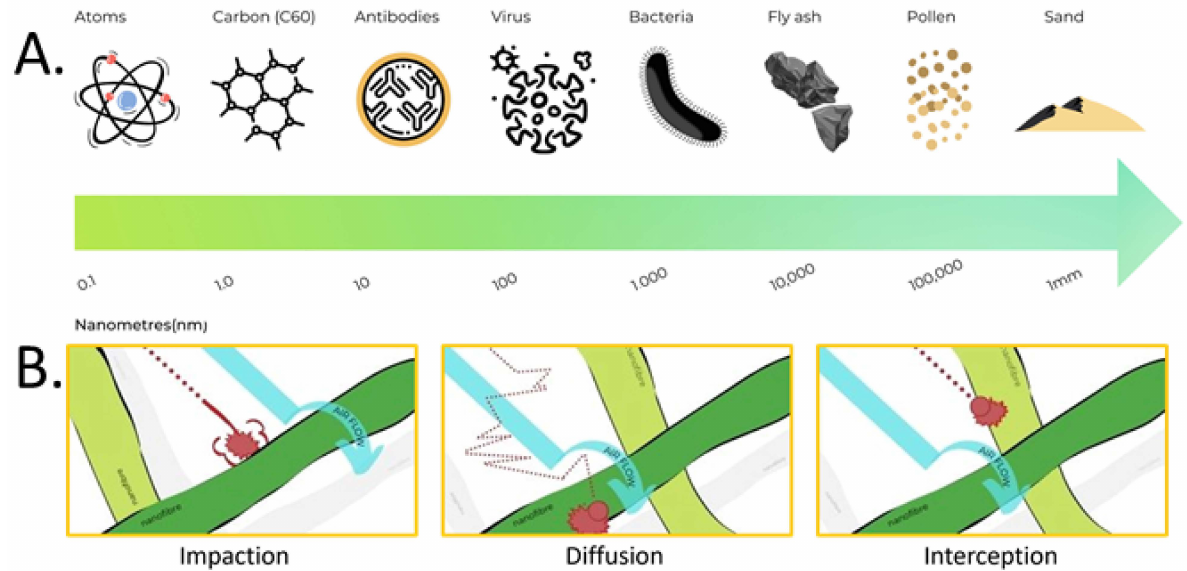
Figure 2. ( A ) Size comparison of particles present in nature; ( B ) the filtration mechanisms associated with electrospun nanofibre